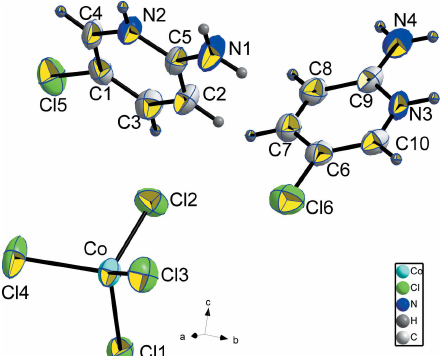
Figure 1 The molecular entities of (C 5 H 6 ClN 2 ) 2 [CoCl 4 ], showing the atom- numbering scheme. Displacement ellipsoids are drawn at the 50% probability